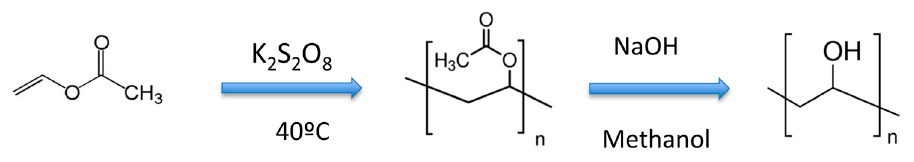
Figure 5. Polyvinyl alcohol (PVA) synthesis.